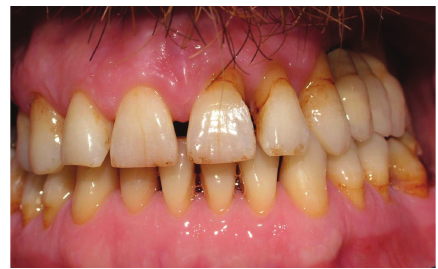
Figure 6: Intraoral view after prosthetic